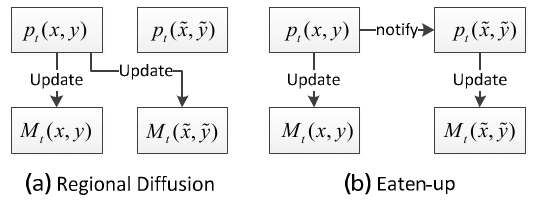
Figure 4. Regional diffusion and eaten-up in BG model update.